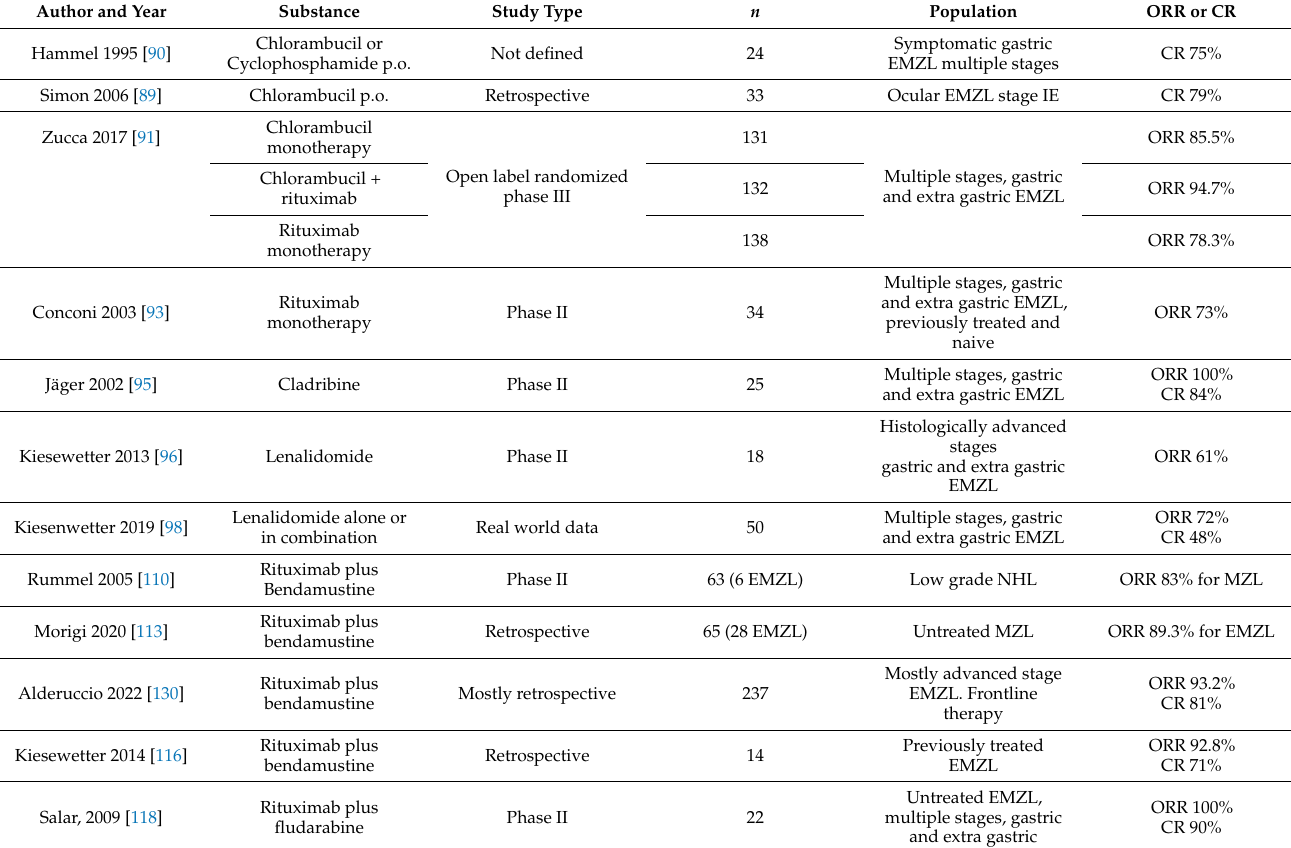
Table 2. Summary of evidence in